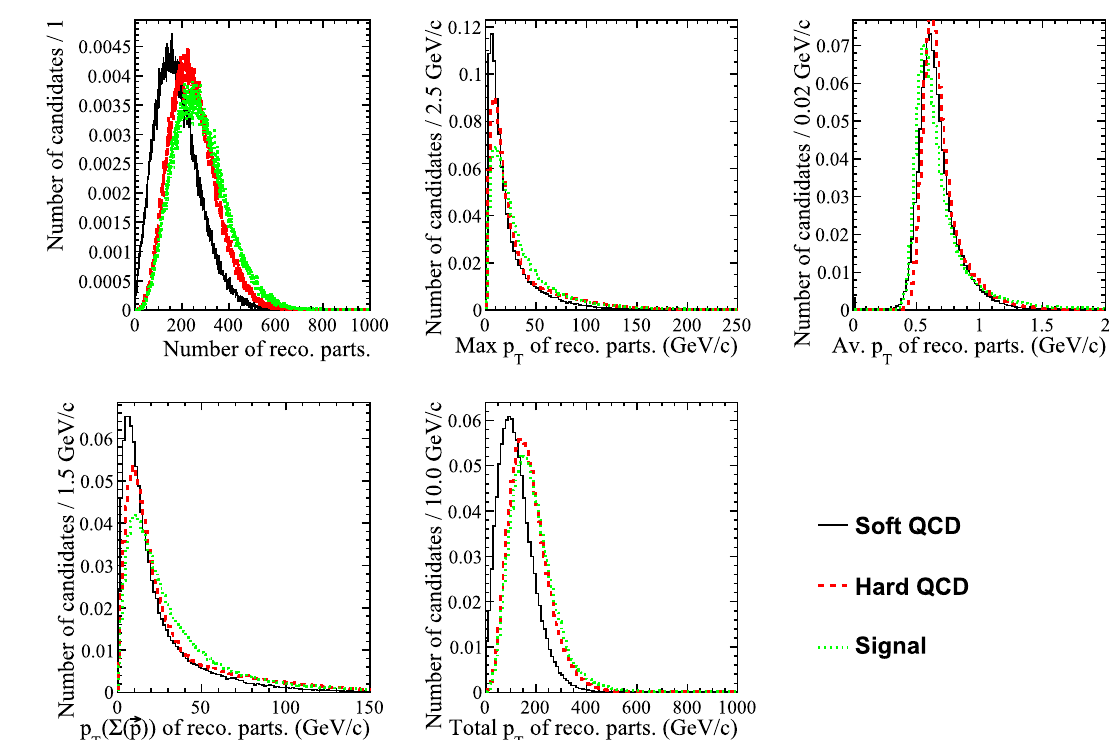
Fig. 36 Distribution of different general event variables at LHCb in events containing a h → A (cid:3) (μ + μ − ) A (cid:3) (μ + μ − ) decay (labelled as sig- nal), soft and hard QCD processes. The processes were all generated with Pythia . The variables displayed are all generated using particles